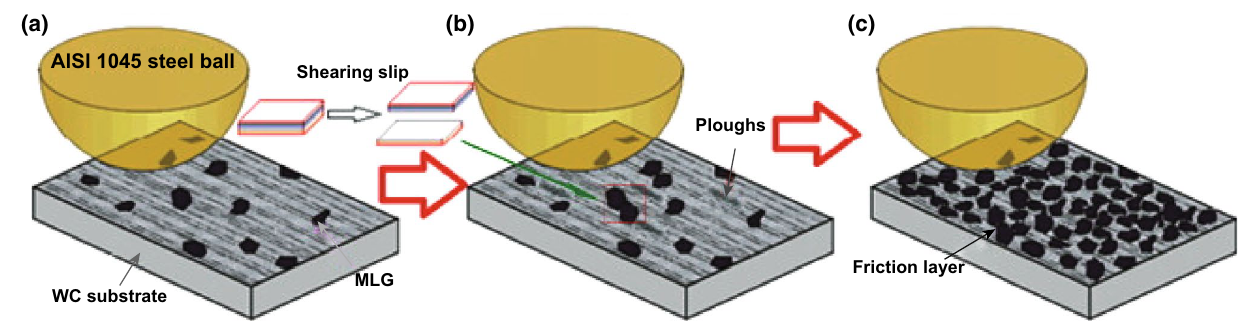
Fig. 20 Schematic of effect mechanism of MLG reinforced WC‑based materials against AISI 1045 steel [178]. Figure panels reproduced from Ref. [178] with permission from Elsevier copyright